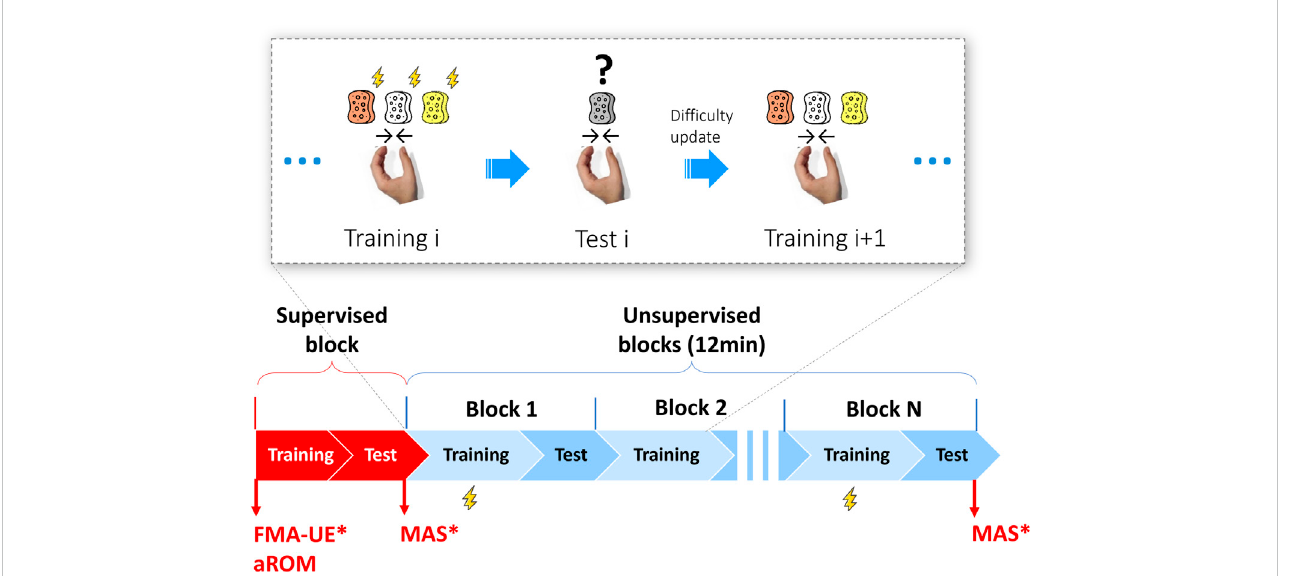
FIGURE 3 Exercisedescriptionandpilotstudyexperimentalprotocol.Top:detailoftheexercisestructure.Ablockiconsistsofatrainingphaseiandatestphasei.In the training phase, the subjects have to consecutively squeeze three virtual sponges of different color rendered by the robot and memorize their stiffness. In the training phase of the blocks where the perturbations were applied, i.e., the perturbation blocks, three fast and three slow perturbations (thunderbolt icon) are applied when subjects switch form one sponge to the following and their hand is relaxed. In the test phase, a random sponge among the three previously memorized isproposed.Subjectshave tosqueeze itandpressthecolorcorrespondingto theidenti fi edstiffness onthepushbuttonkeyboard.This corresponds to one therapy task repetition. The dif fi culty level (i.e., relative stiffness difference between sponges) is progressively adapted based on the subject performance and, ateach dif fi culty update, anew training phase (andblock)isstarted. Thus, each subject performs adifferentnumber of blocks(with different duration and number of task repetitions) within the same exercise duration (12 min). Bottom: The pilot study includes a supervised (familiarization) block, followed by unsupervised blocks during which the subject independently performs the exercise, while the experimenter observes the session. At the beginning ofthe experiment, all subjects undergothe robotic assessment of theaROM, while onlystroke subjects perform theFugl-Meyer assessment of the upper extremity (FMA-UE) and the Modi fi ed Ashworth Scale (MAS) of long fi nger fl exors, which is repeated at the end of the last block. Perturbation blocks were designed to be at least 3 min apart, meaning that not all the training phases have perturbations (maximum three over 12 min). * = performed only for stroke subjects.